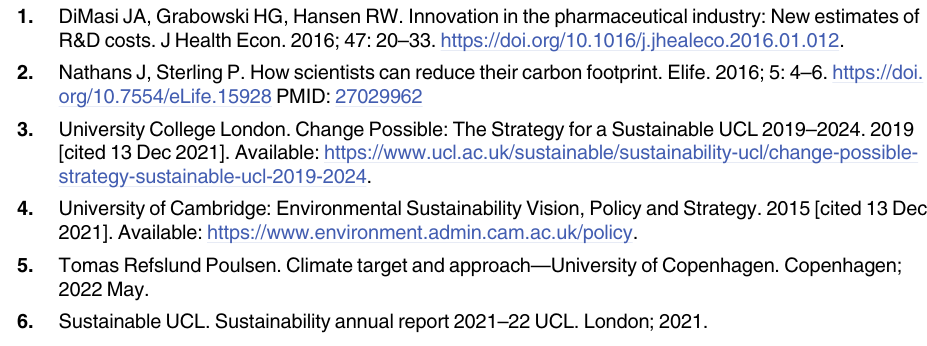
S2 Fig. Costs associated with single-use and re-use of tubes and flasks for 10 years includ- ing salary of support staff. ( A-C ) Running costs of a 10-year period for (A-B) 50mL conical tubes and (B-C) conical 1L flasks including costs associated with salary of support staff for re- use scenario. (B) Presents the details of (A,C) in x1000 GBP for the scenario of 52 000 items used per year. S1 Table. CO e calculation of labware. This table details the calculation used in this study. 2